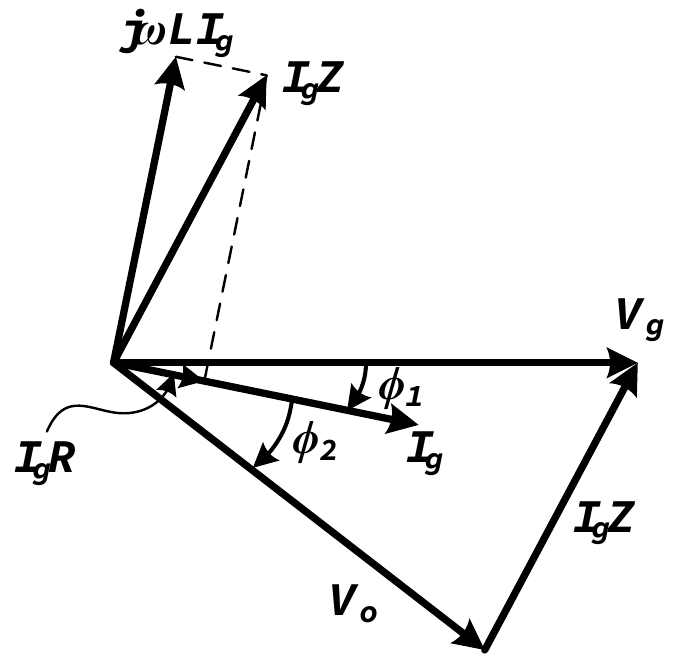
Figure 2. Phasor diagram of steady state operation.